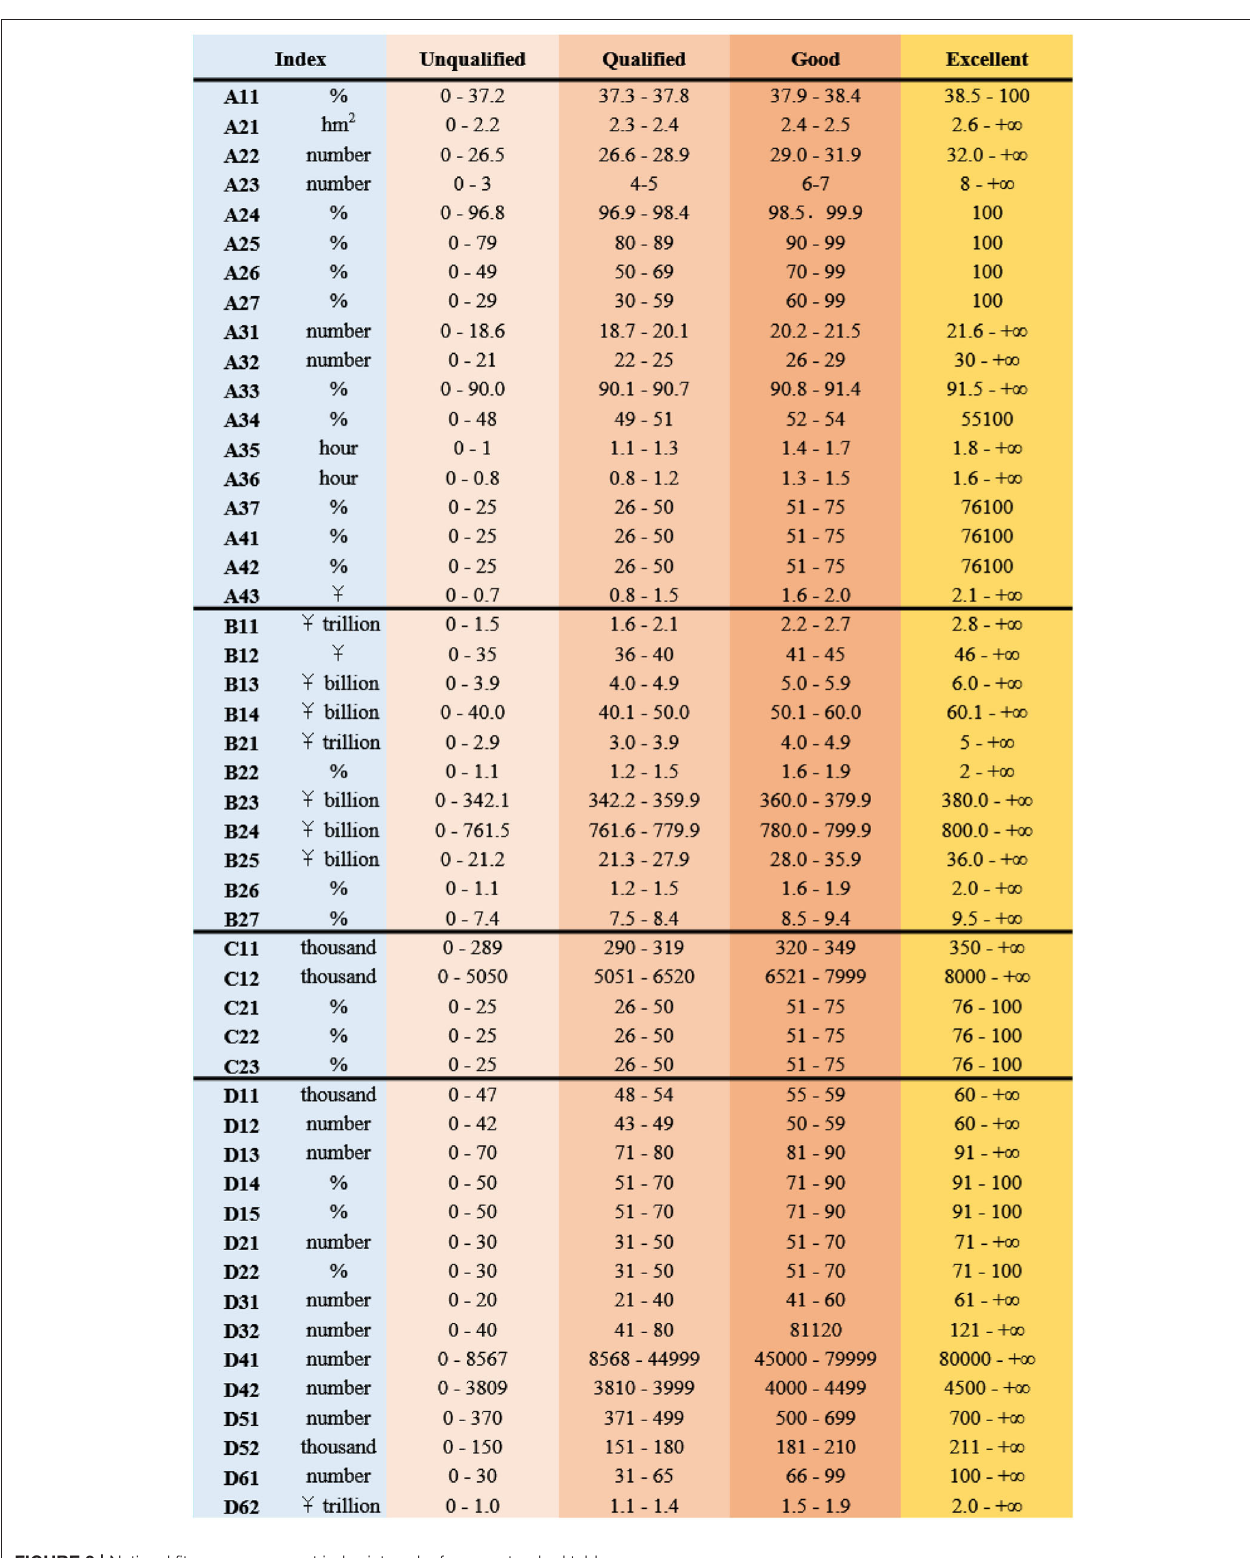
Frontiers in Public Health |